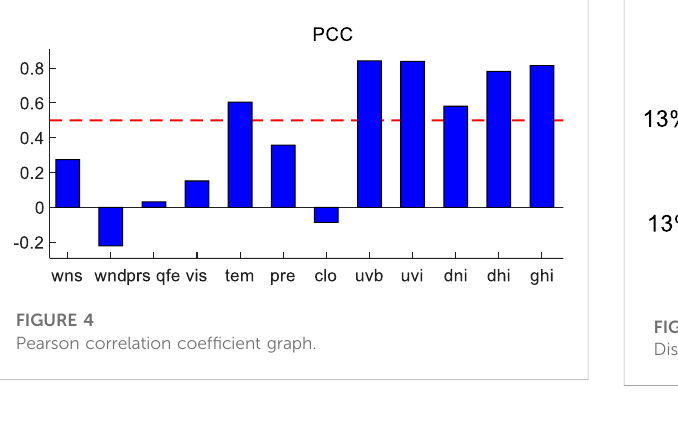
FIGURE 4 Pearson correlation coef fi cient graph.